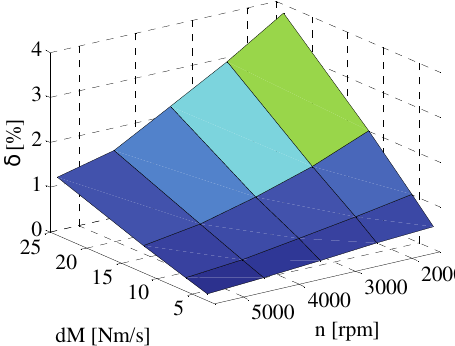
Fig. 12. Error δ in function of constant engine speed n and torque increase dM